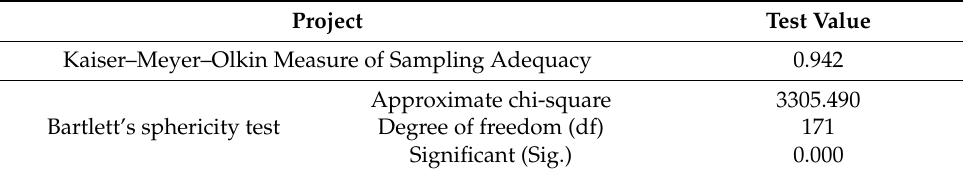
Table 2. Test results using KMO and